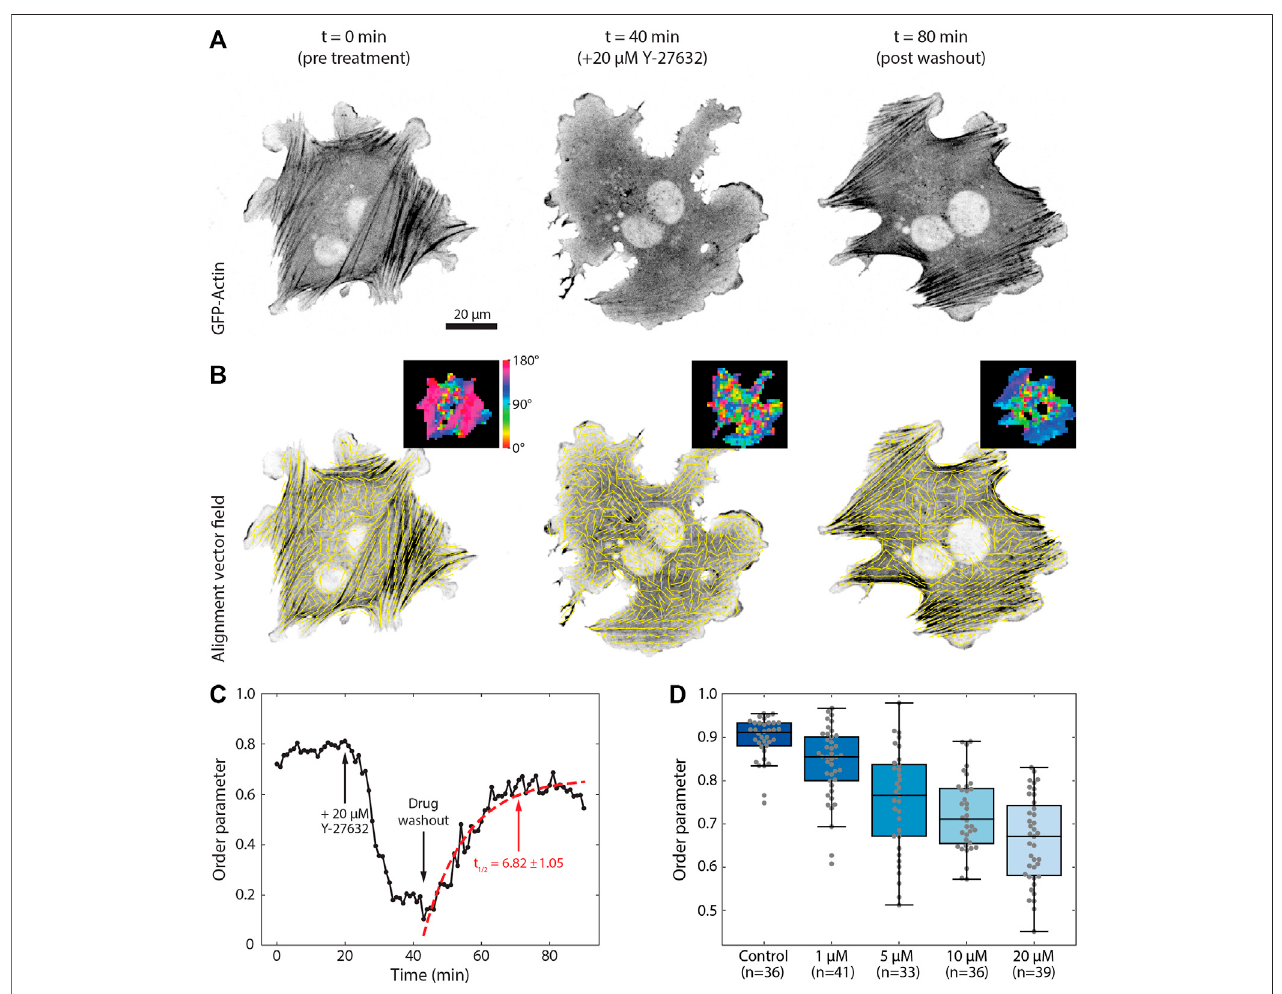
FIGURE 8 | Measuring kinetics of alignment. (A) An NIH 3T3 fi broblast transfected with GFP-actin is shown before, during, and after washout of 20 μ M Y-27632. (B) Local alignment was calculated for each frame in the time series using a window size of 17 px and an overlap of 50 % . Yellow vectors indicate the local direction of alignment in the image while insets show the angle of orientation for each window. (C) Plot of the calculated order parameter over time for a neighborhood radius of 2 x vectors. Arrows indicate the time points of addition of Y-27632 and wash out of the drug. Red dashed line indicates the fi t to Eq. 7 . (D) Boxplots of the average order parameter for fi broblasts treated for 30 min with different concentrations of Y-27632 and then fi xed and stained with phalloidin to label actin. Each dot represents the median order parameter of a single cell with a window size of 33 px , overlap of 50 % , and neighborhood radius of 2 x .